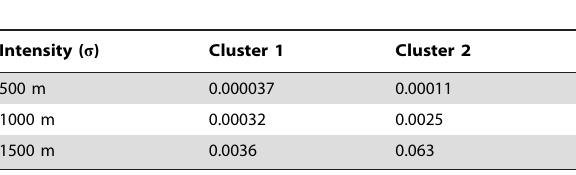
Table 1. Pseudo p -values as calculated by the STPSS associated with Clusters 1 and 2 for the hotspots of varying